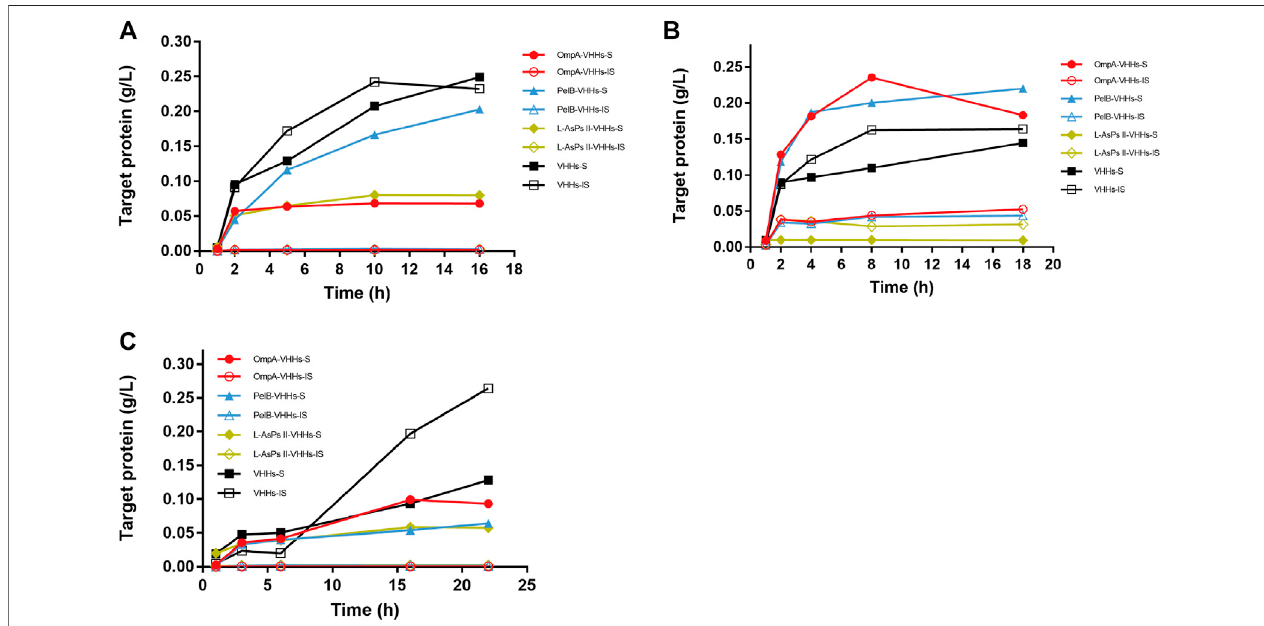
FIGURE 2 | The expression of anti-GFP VHHs with different SPs in IPTG-induced E. coli Origami2 (DE3) (A) , ArcticExpress (DE3) (B) , and HMS174 (DE3) (C) . The time-dependent expression level of VHHs alone (black) and VHHs with OmpA (red), PelB (blue), and L-AsPs II-SP (yellow). S, soluble fraction; IS, insoluble fraction. ConcentrationofIPTG:0.02 mM.Inductiontemperature:25 ° C.M:Enhanced3-colorRegularRangeSMOBIOProteinMarker(PA2511)(10.0 – 180 kDa)purchasedfrom SMOBIO.